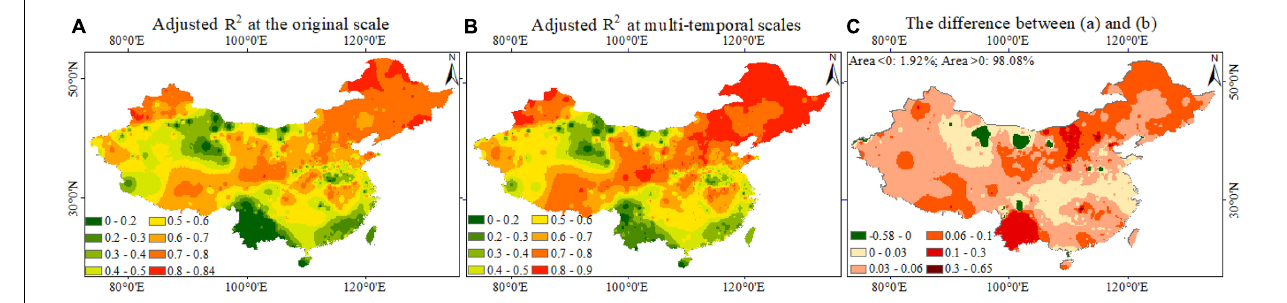
TABLE 2 | Adjusted R 2 of stepwise multiple linear regression (SMLR) based on climatic factors at the half-month scale (R 2 HM ) and multi-spatial scales (R 2 m ). Broadleaf forest Mixed forest Woody savannas Savannas